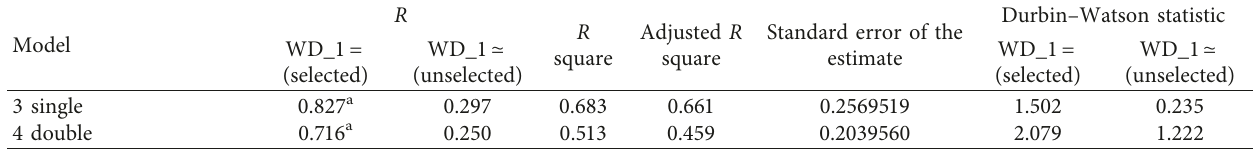
Table 5: Results of regression analysis with regard to Model 3 (single window) and 4 (double window).